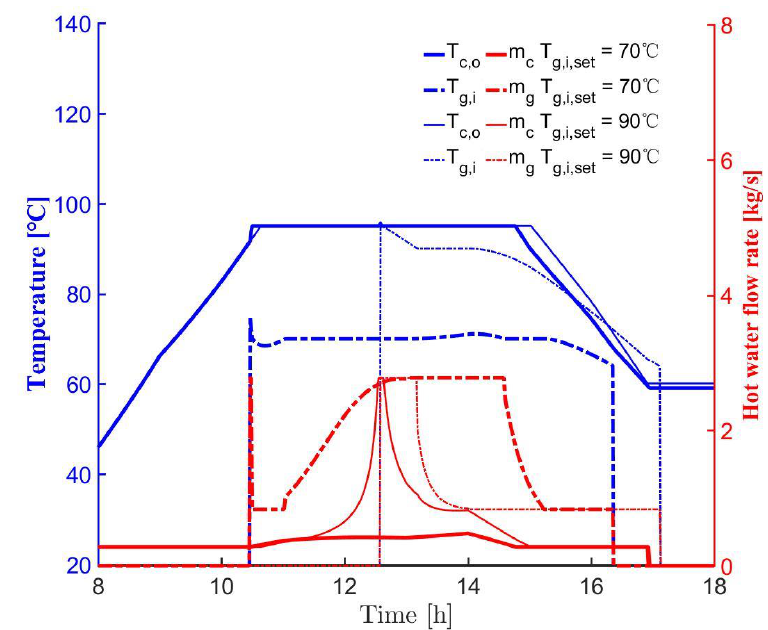
Figure 10. Hot water temperature and flow rate for different Tg , i , set